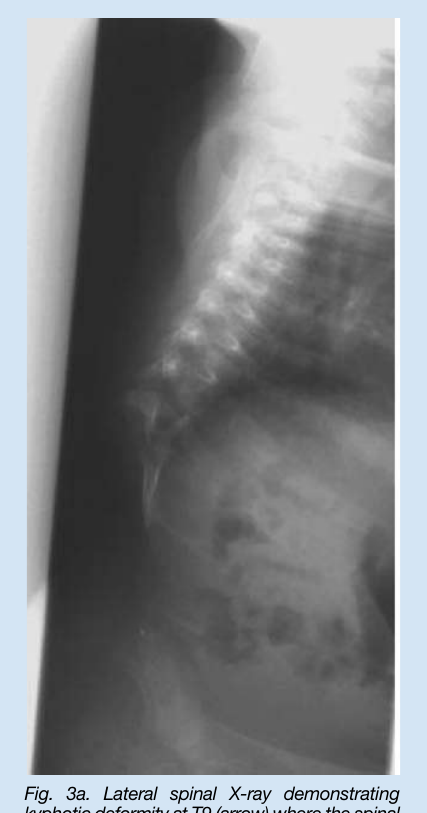
Fig. 3a. Lateral spinal X-ray demonstrating kyphotic deformity at T9 (arrow) where the spinal vertebrae end abruptly.